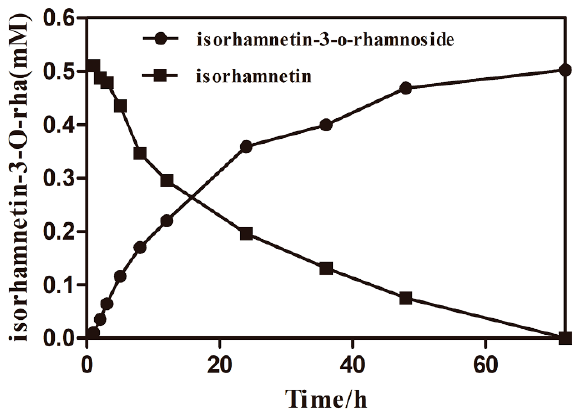
Figure 8. Time courses of isorhamnetin-3- O -rhamnoside production and isorhamnetin reduction in a synergistic reaction system. The circle represents isorhamnetin-3- O -rhamnoside. The triangle represents isorhamnetin.